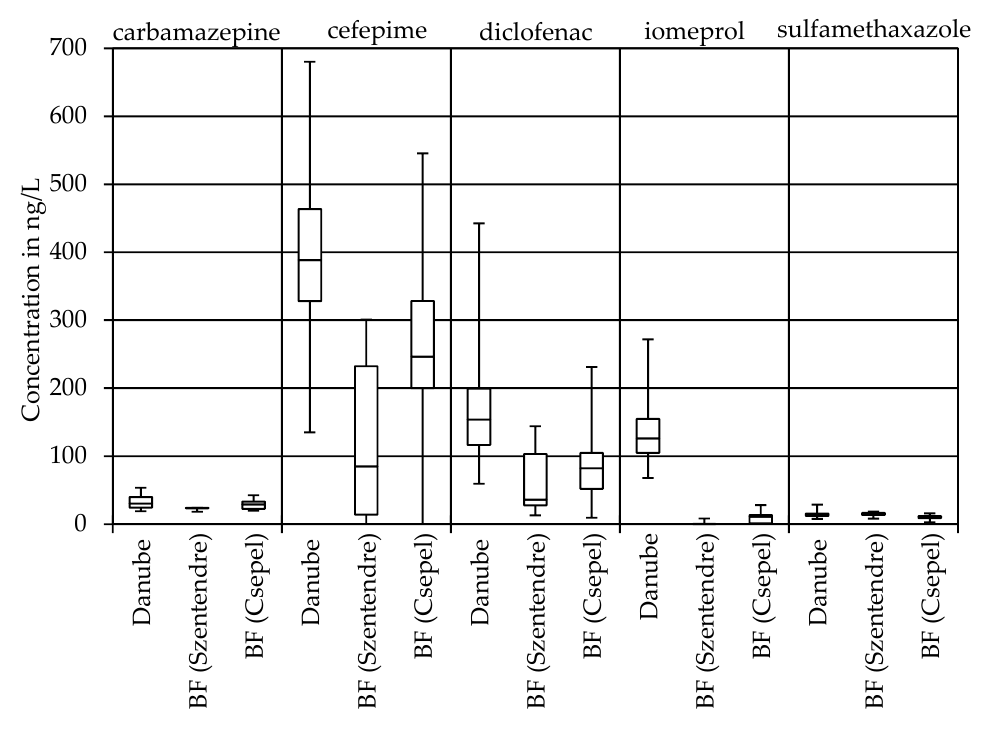
Figure 4. Boxplots representing concentrations of pharmaceuticals and X-ray contrast media in the Danube River water and bank filtrate.